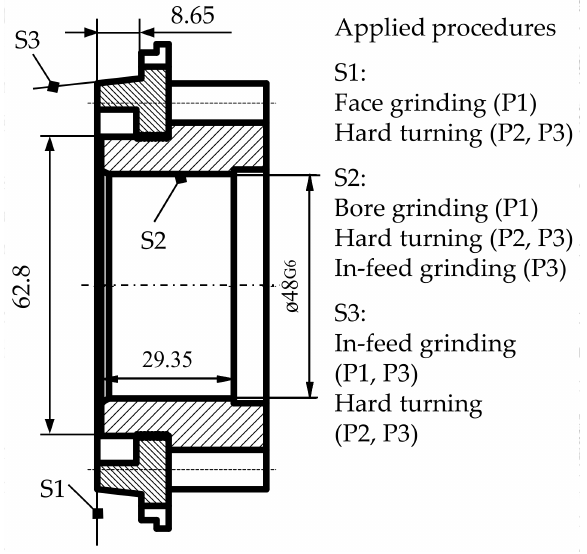
Figure 2. Geometrical and cutting